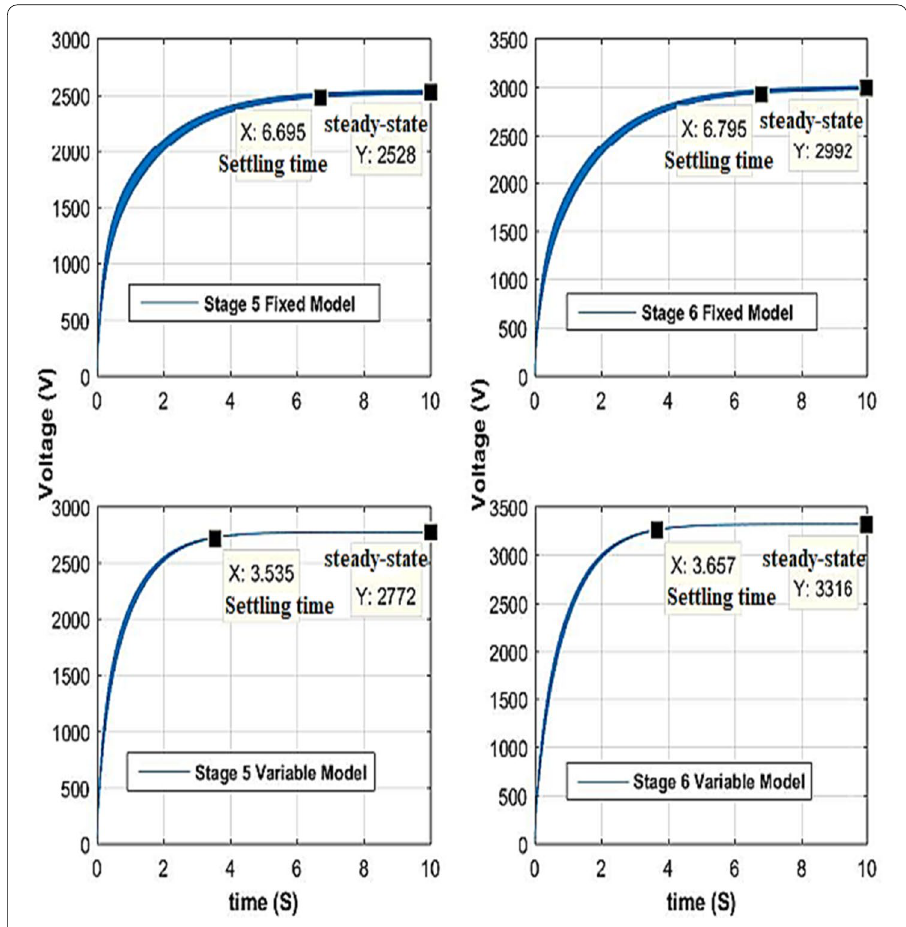
Fig. 9 Settling time, transient and steady state value of output voltage of stages five and six of both models